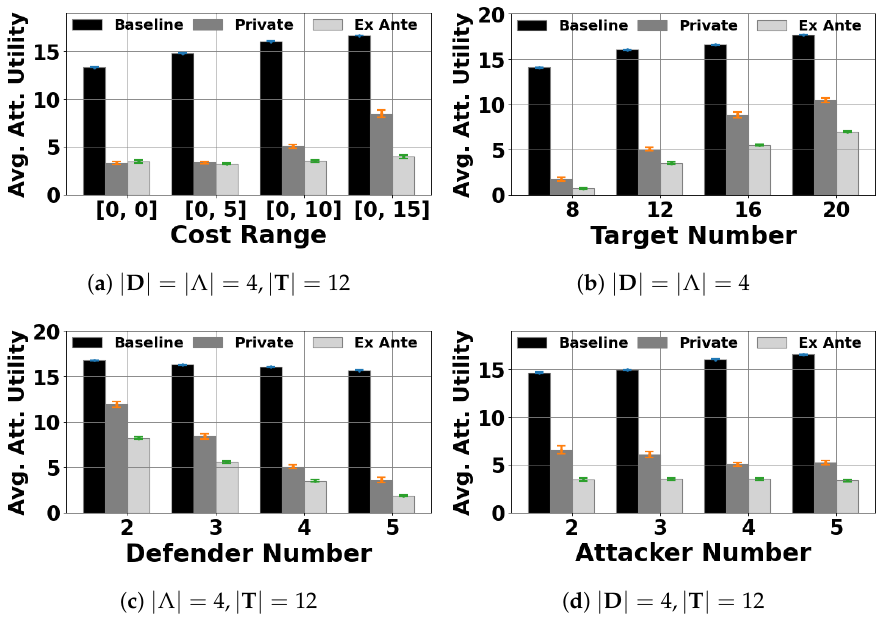
Figure 2. Average attacker utility: the defenders’ cost range is fixed to [ 0,10 ] in sub-figures ( b – d